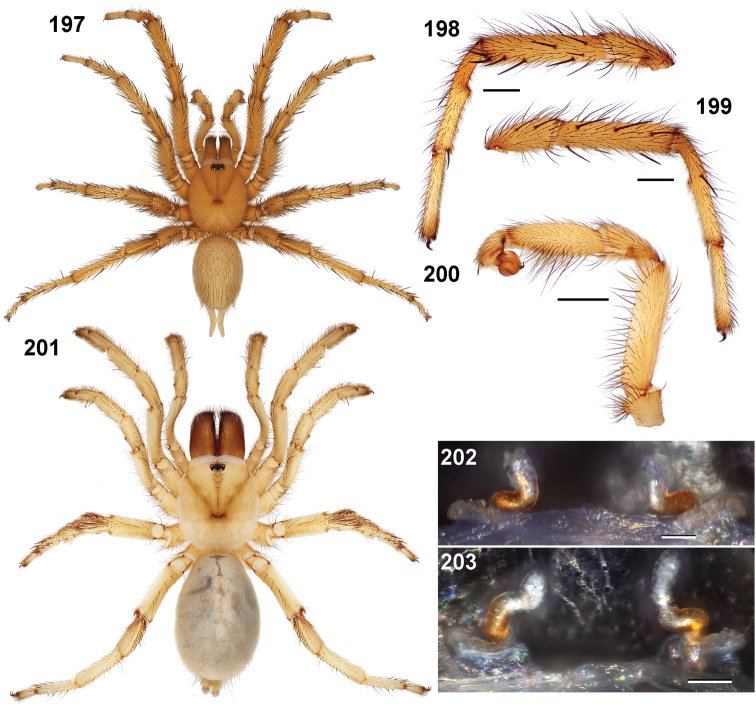
Aptostichus hedinorum sp. n. 197–200 male holotype (MY3779); scale bars = 1.0mm 197 habitus [806056] 198 retrolateral aspect, leg I [806048] 199 prolateral aspect, leg I [806052] 200 pedipalp, leg I [806054] 201 female habitus (MY3781), from type locality [806058] 202, 203 cleared spermathecae, female paratype (AP675) [806608] and additional specimen from type locality (MY3781) [806702]; scale bars = 0.1mm.